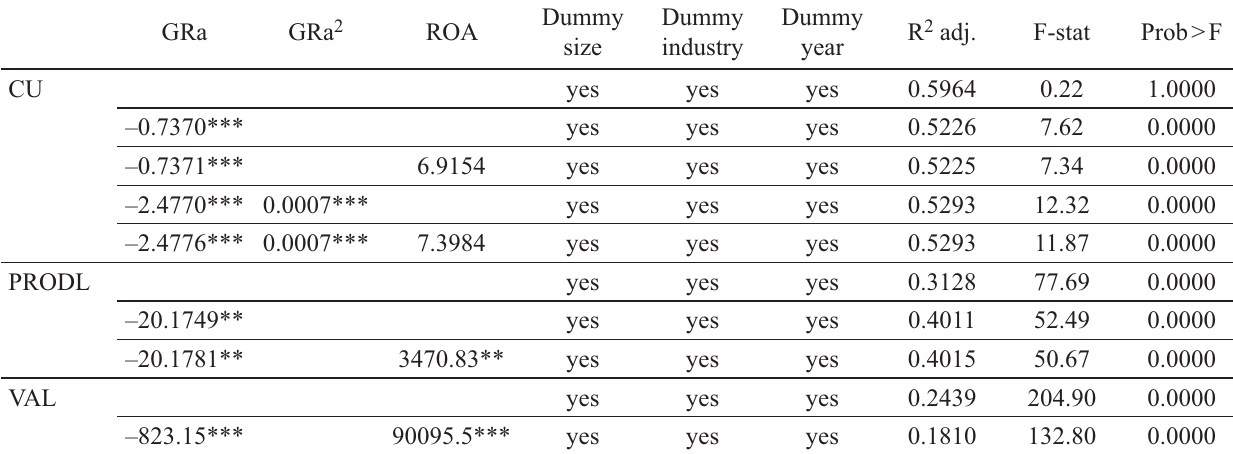
Table 8. Fixed effects models for the dependence of capacity utilization and productivity on the growth rate